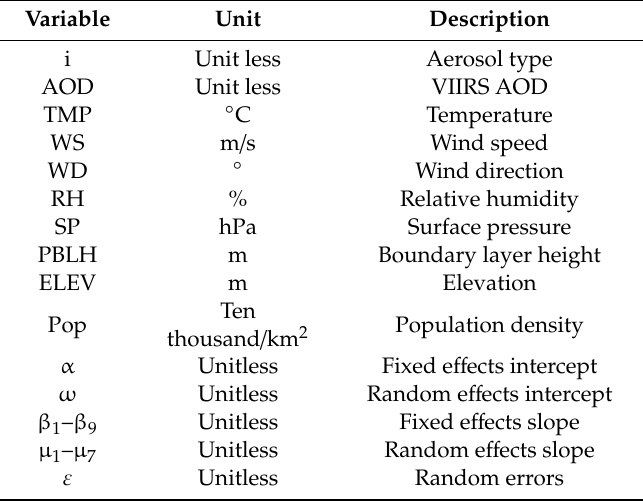
Table 2. Parameters used in this study.